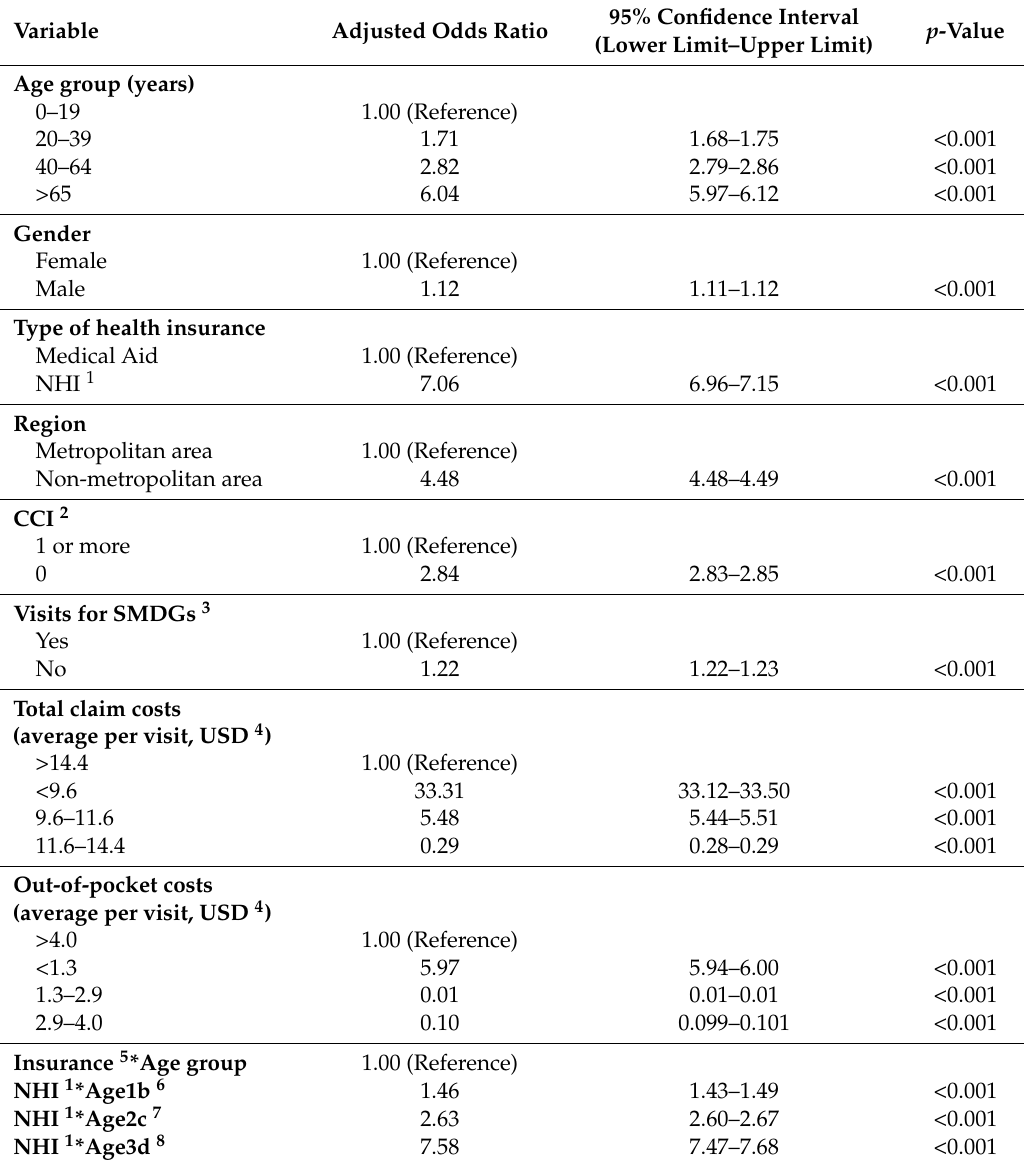
Table 2. Factors for choosing the public health clinics over private